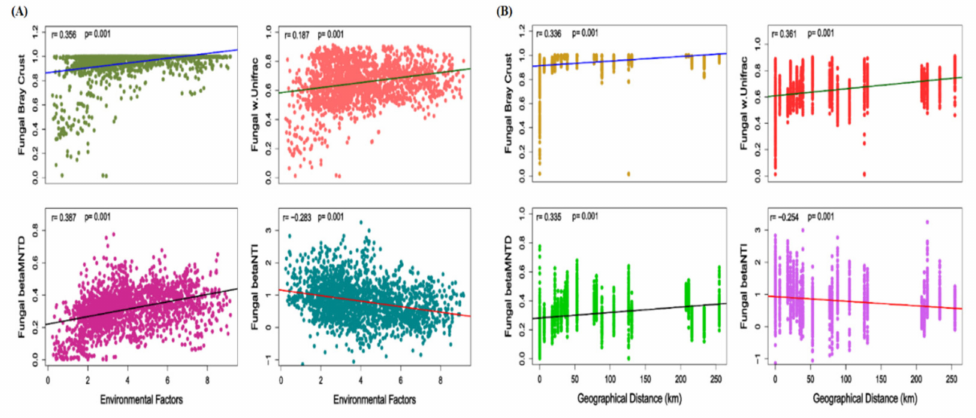
Figure 8. ( A ) Scatter plot diversity indices on Mantel test Spearman correlation “r” show the relationship of taxonomic, phylogenetic null model-based and β NTI values of fungal communities with environmental variables (Euclid based distance). ( B ) Scatter plot diversity indices on Mantel test Spearman correlation “r” show the relationship of taxonomic, phylogenetic null model-based, and β NTI values of fungal communities with geographic